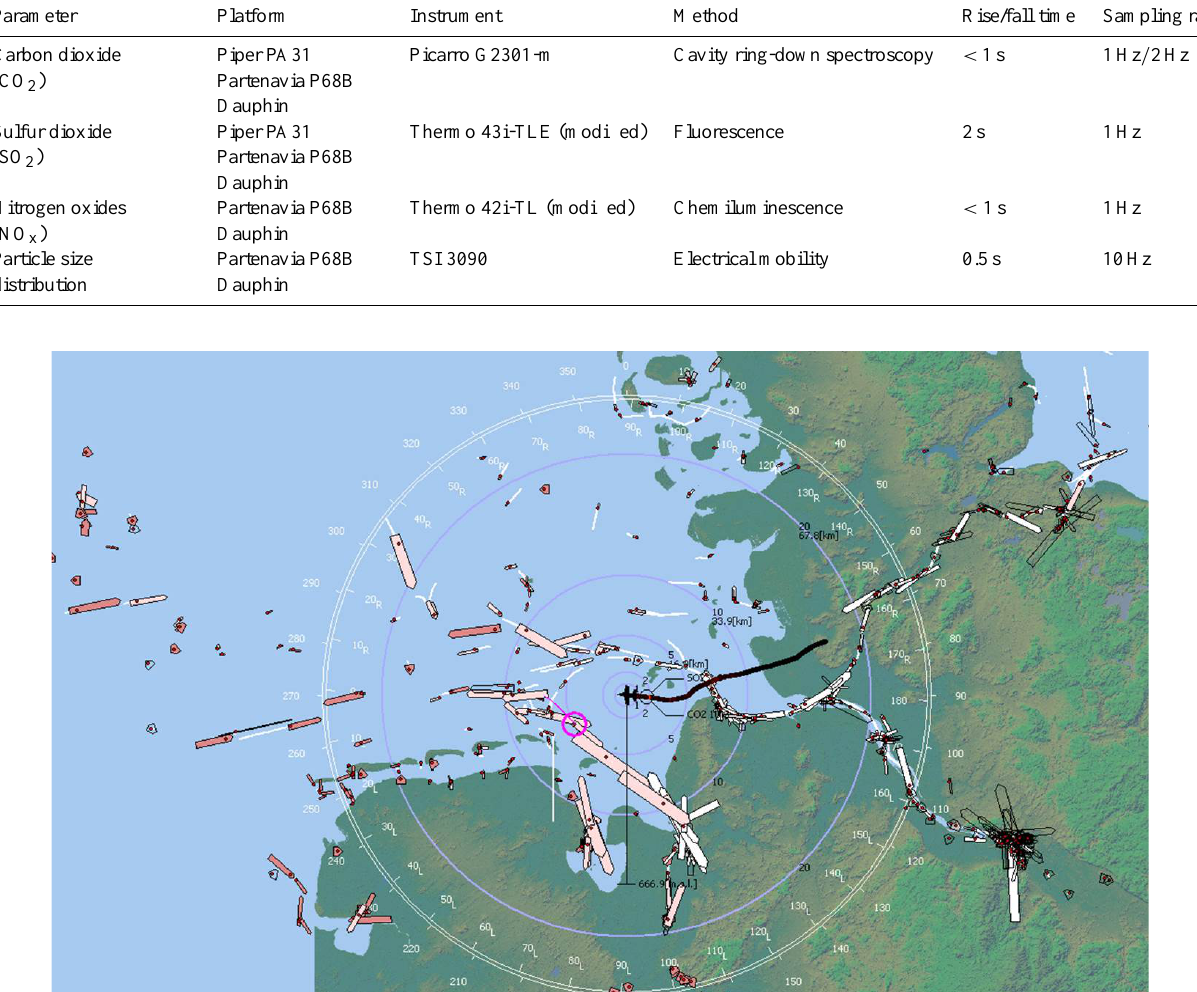
Table 2. Overview of instrumentation used on the different platforms.